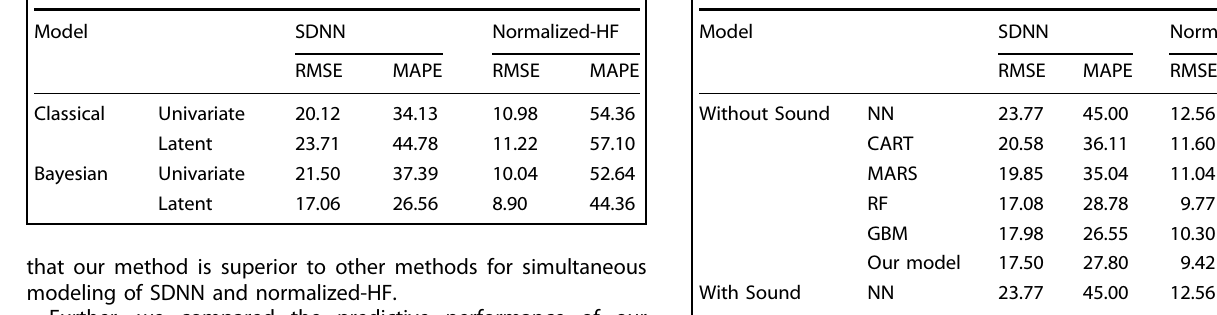
Table 3. Comparing predictive performance of machine learning models with and without sound as an input.